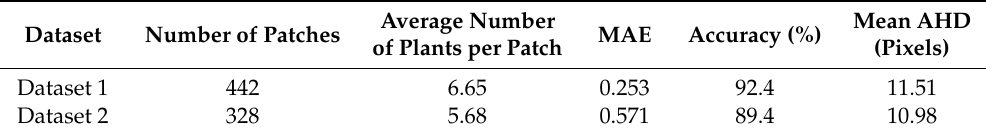
Table 4. Plant counting and detection evaluation results for investigated image scenes (MAE: Mean absolute error; AHD: Average Hausdorff distance).